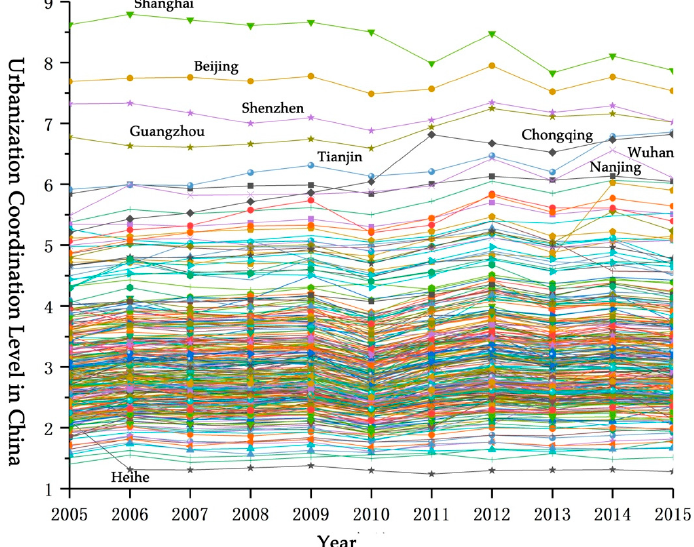
Figure 3. Urbanization coordination levels of sample cities from 2005 to 2015.